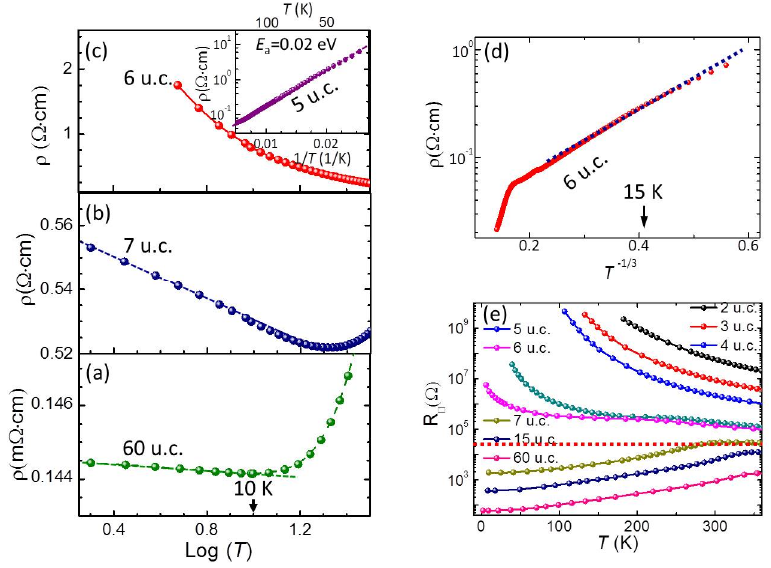
Figure 13. The resistivity versus Log( T ) for ( a ) 60, ( b ) 7, and ( c ) 6 u.c. LSMO films on STO (001). The inset in ( c ) shows the logarithmic plot of resistivity of a function of 1/ T for 5 u.c. film. ( d ) Logarithmic plot of resistivity as a function of 1/ T 1/3 for 6 u.c. LSMO. ( e ) T dependence of the sheet resistance for different thicknesses of LSMO films. The red dotted line indicates the Ioffe–Regel (IR) limit for the onset of strong localization. Figure is adapted from Ref.